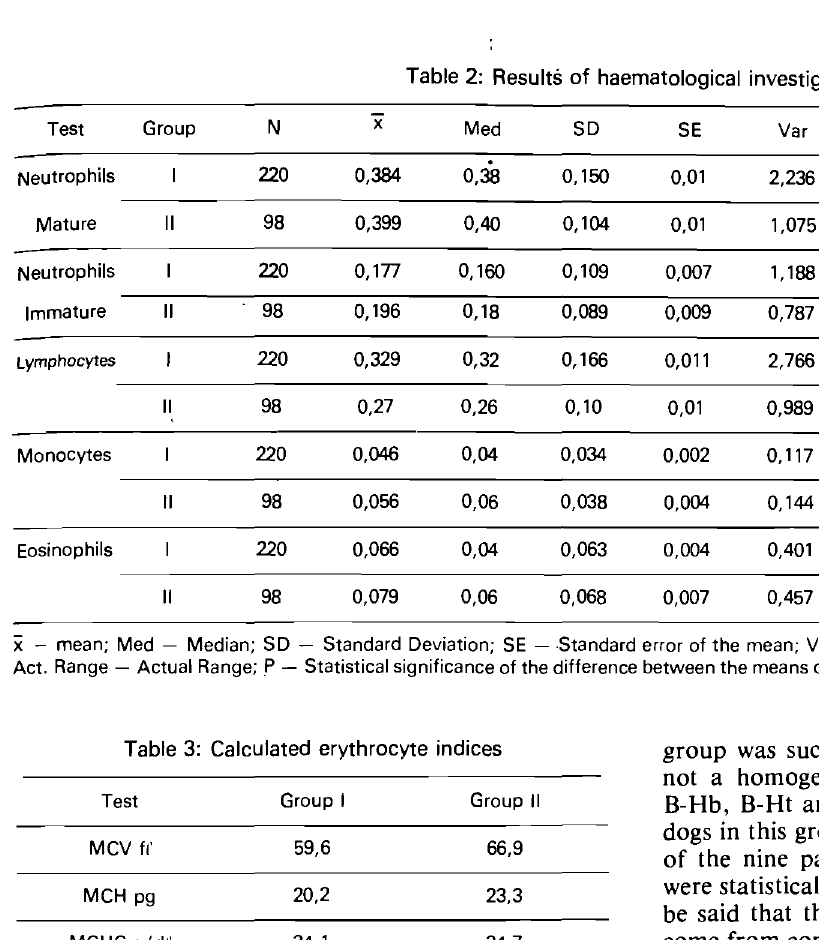
Table 2: Results of haematological investigation